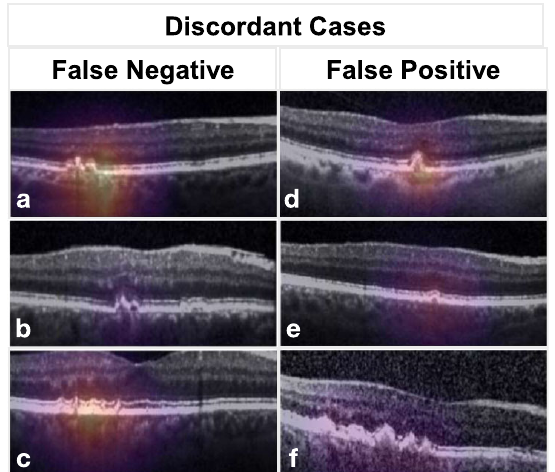
Fig. 5 Composite of B-scan images of example cases with disagreement between multiple graders. Top row: IHRF, middle row: SDD, bottom row, hDC. In a , Aan IHRF is clearly visible (white circle) but is in a region of atrophy. Some graders excluded consideration of the feature as a result. This fi nding was correctly detected by the algorithm. b A tiny brighter dot (arrow) is